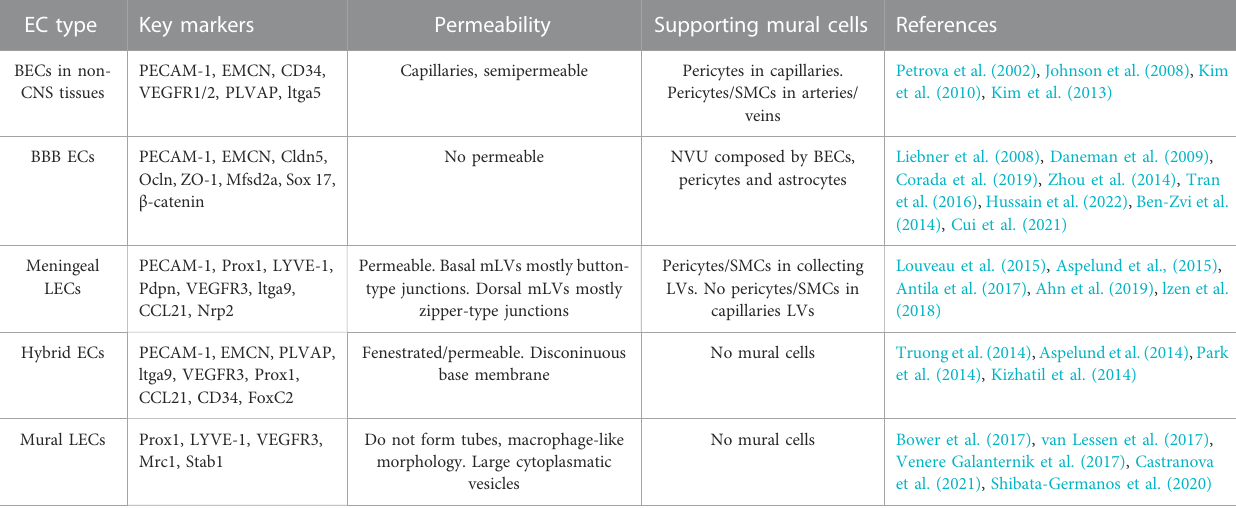
TABLE 1 Comparison between CNS endothelial cell